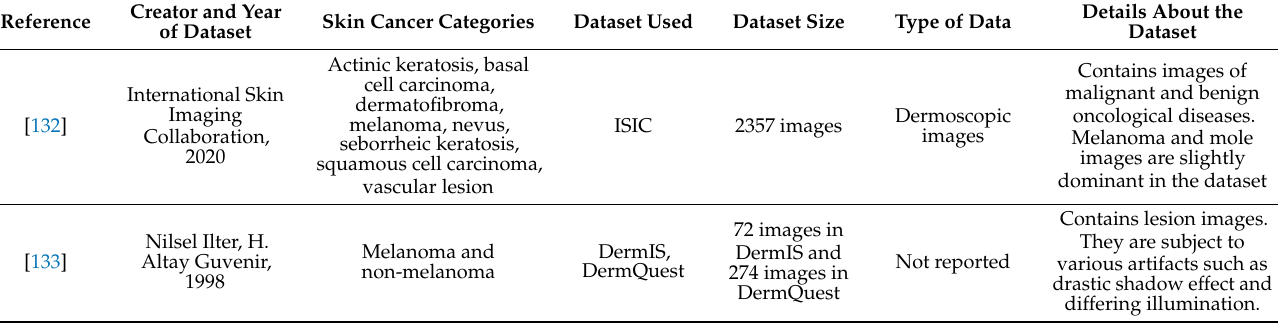
Table 3. List of various skin cancer datasets employed by previous